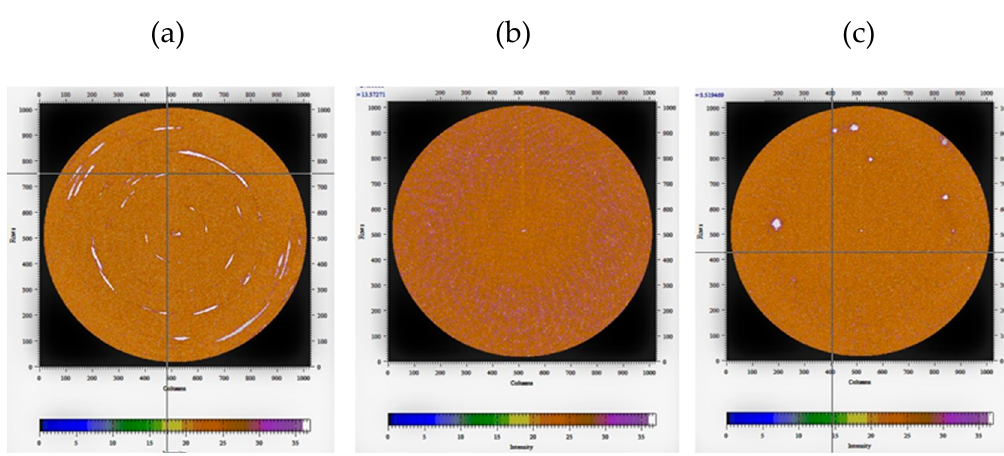
Figure 3. The X ‐ ray diffraction patterns of EV1. ( a ) Crystalline phase at room temperature; ( b ) Isotropic phase taken at 200 ℃; ( c ) Incipient crystalline phase at 160 ℃ on cooling from isotropic phase. It can be seen that this compound scatters X ‐ ray poorly.